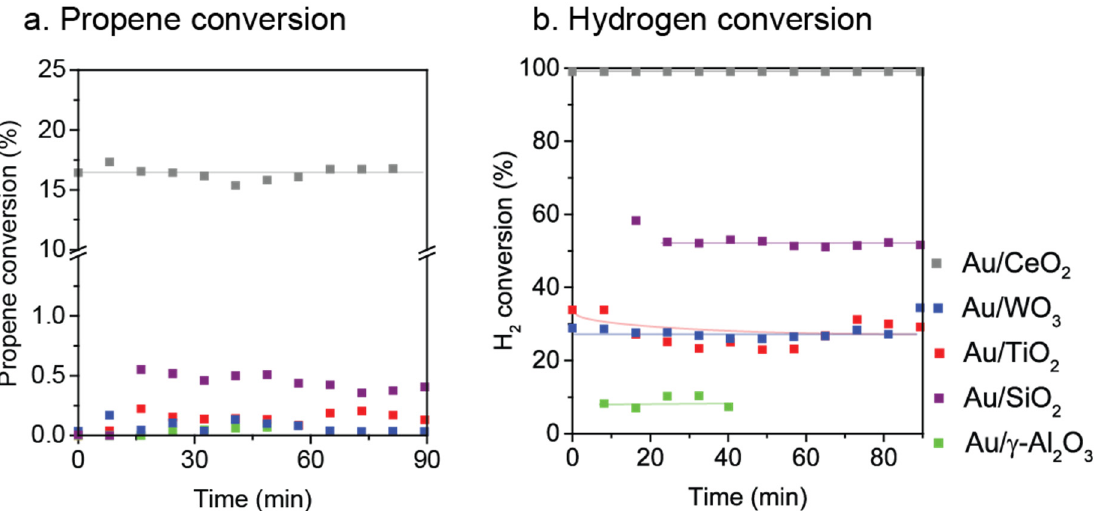
Figure 3. Oxidation of propene in the presence of the supported gold catalysts at 200 °C ( a ) C 3 H 6 conversion, ( b ) H 2 conversion. Conditions: 150 mg of catalyst, 25 mL/min flow of 10% of each C 3 H 6 ,